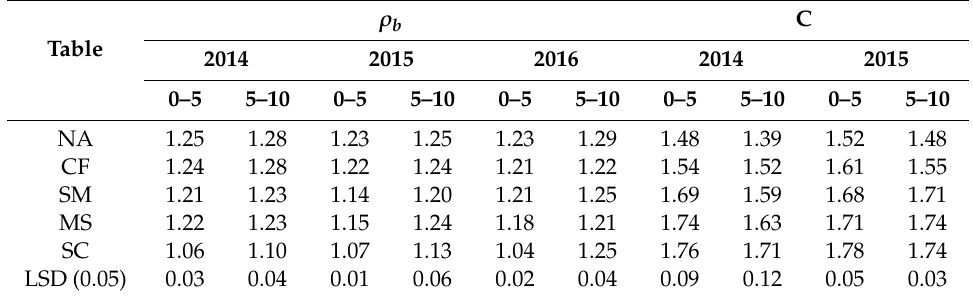
Table 3. Bulk density ( ρ b , g cm − 3 ), total porosity (TP, %), and total carbon (C, %) in the 0–5 and 5–10 cm soil layers by soil amendment treatment in maize and year.